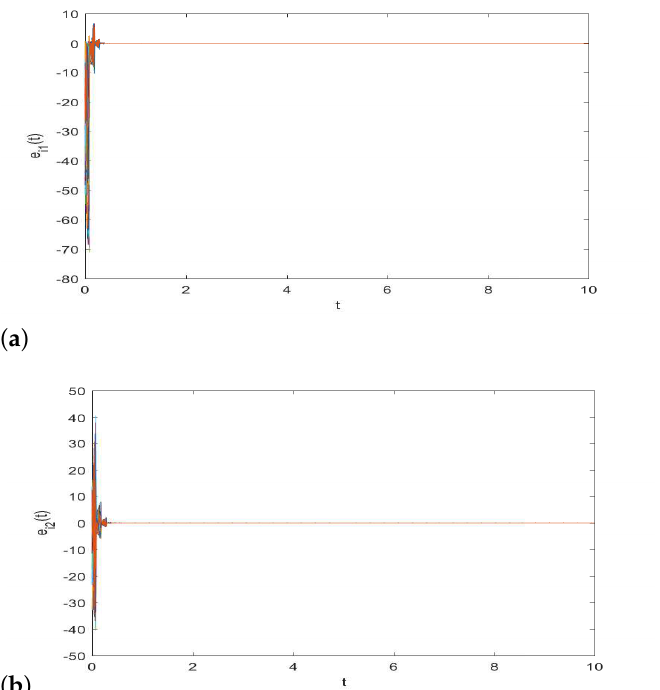
Figure 3. The state of synchronization errors in multi-link complex networks (40) under the hybrid impulsive pinning control. ( a ) e i 1 ( t ) ; ( b ) e i 2 ( t )